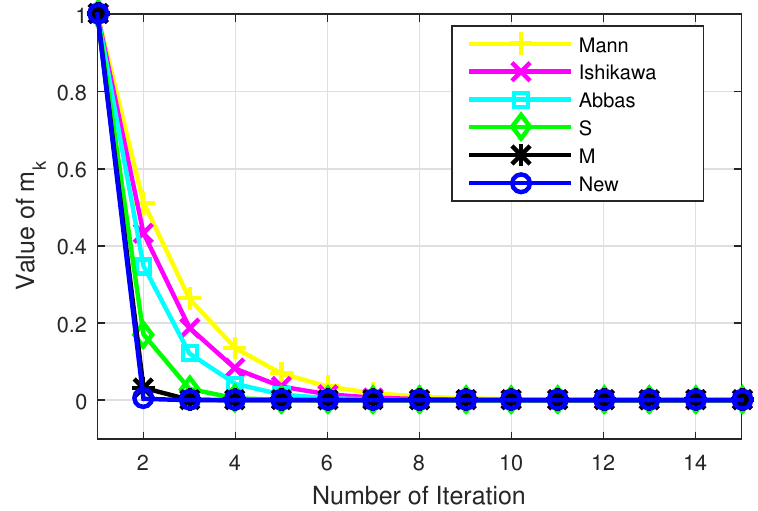
Figure 1. Graph corresponding to Table